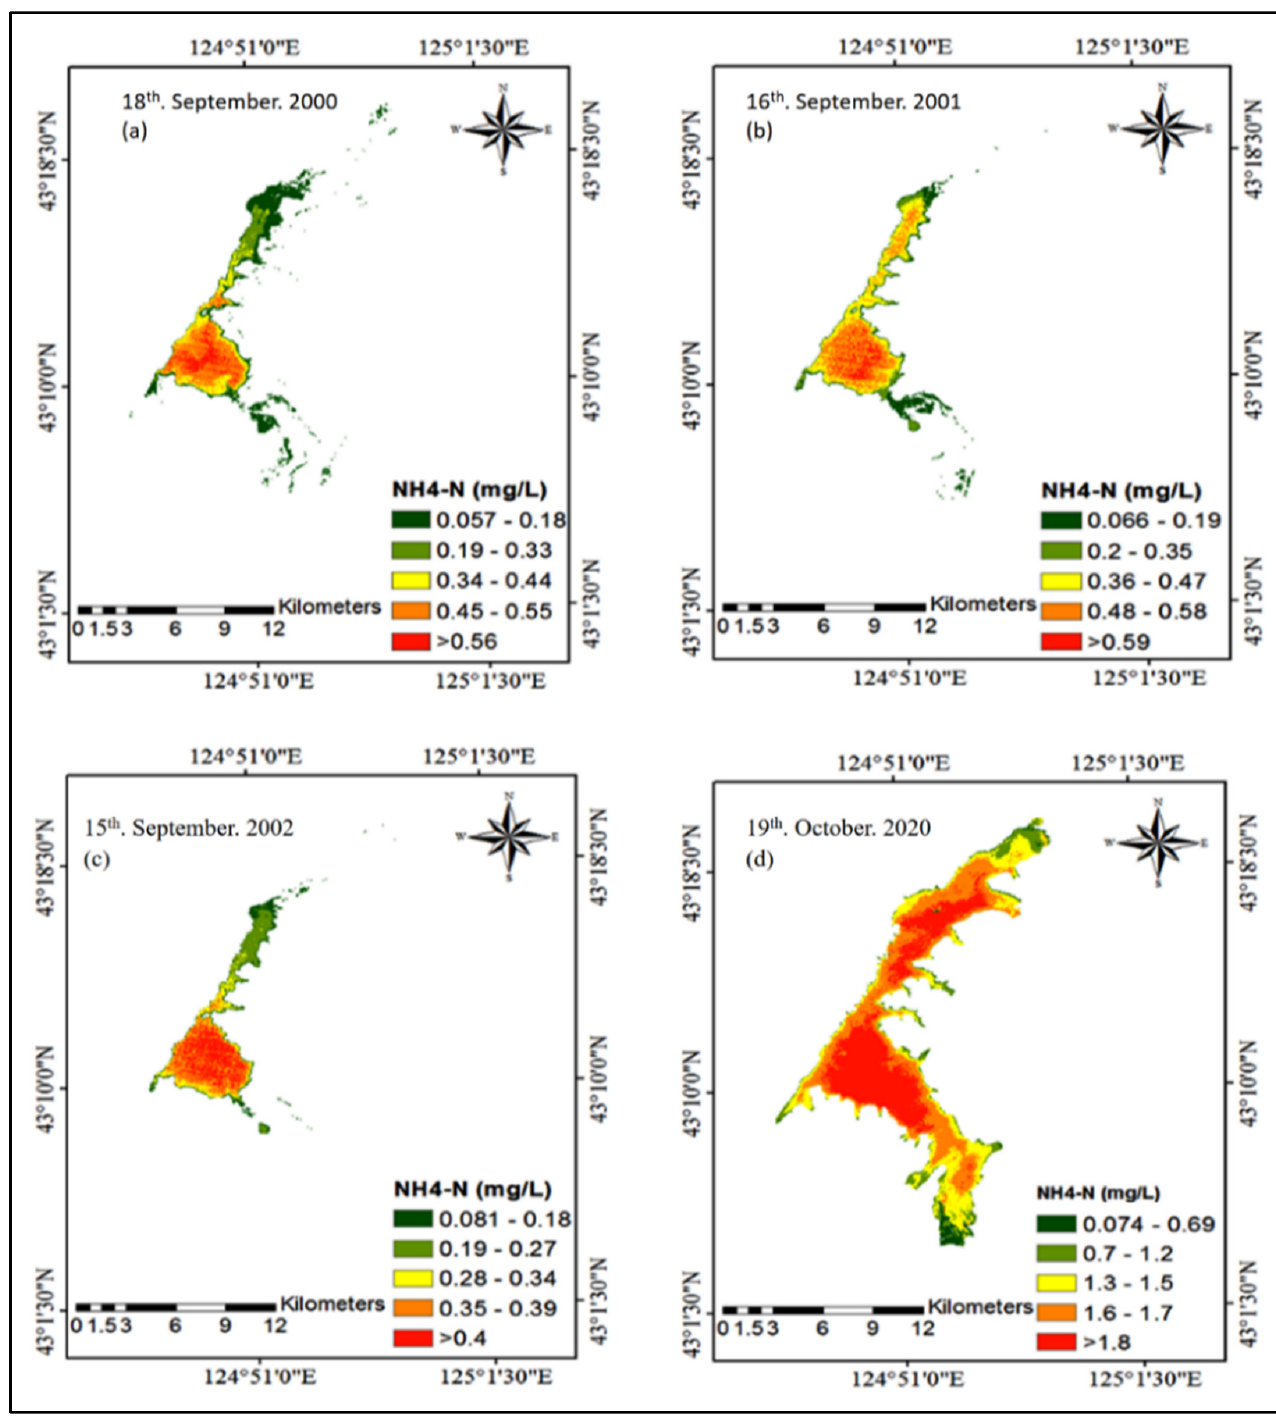
Figure 6. Spatial distributions of NH 4 -N (( a ) spatial distributions of NH 4 -N on 18 September 2000, ( b ) spatial distributions of NH 4 -N on 16 September 2001, ( c ) spatial distributions of NH 4 -N 15 September 2002, ( d ) spatial distributions of NH 4 -N on19 October 2020), estimated via models generated from Landsat (TM, ETM, and OLI8) in Erlong